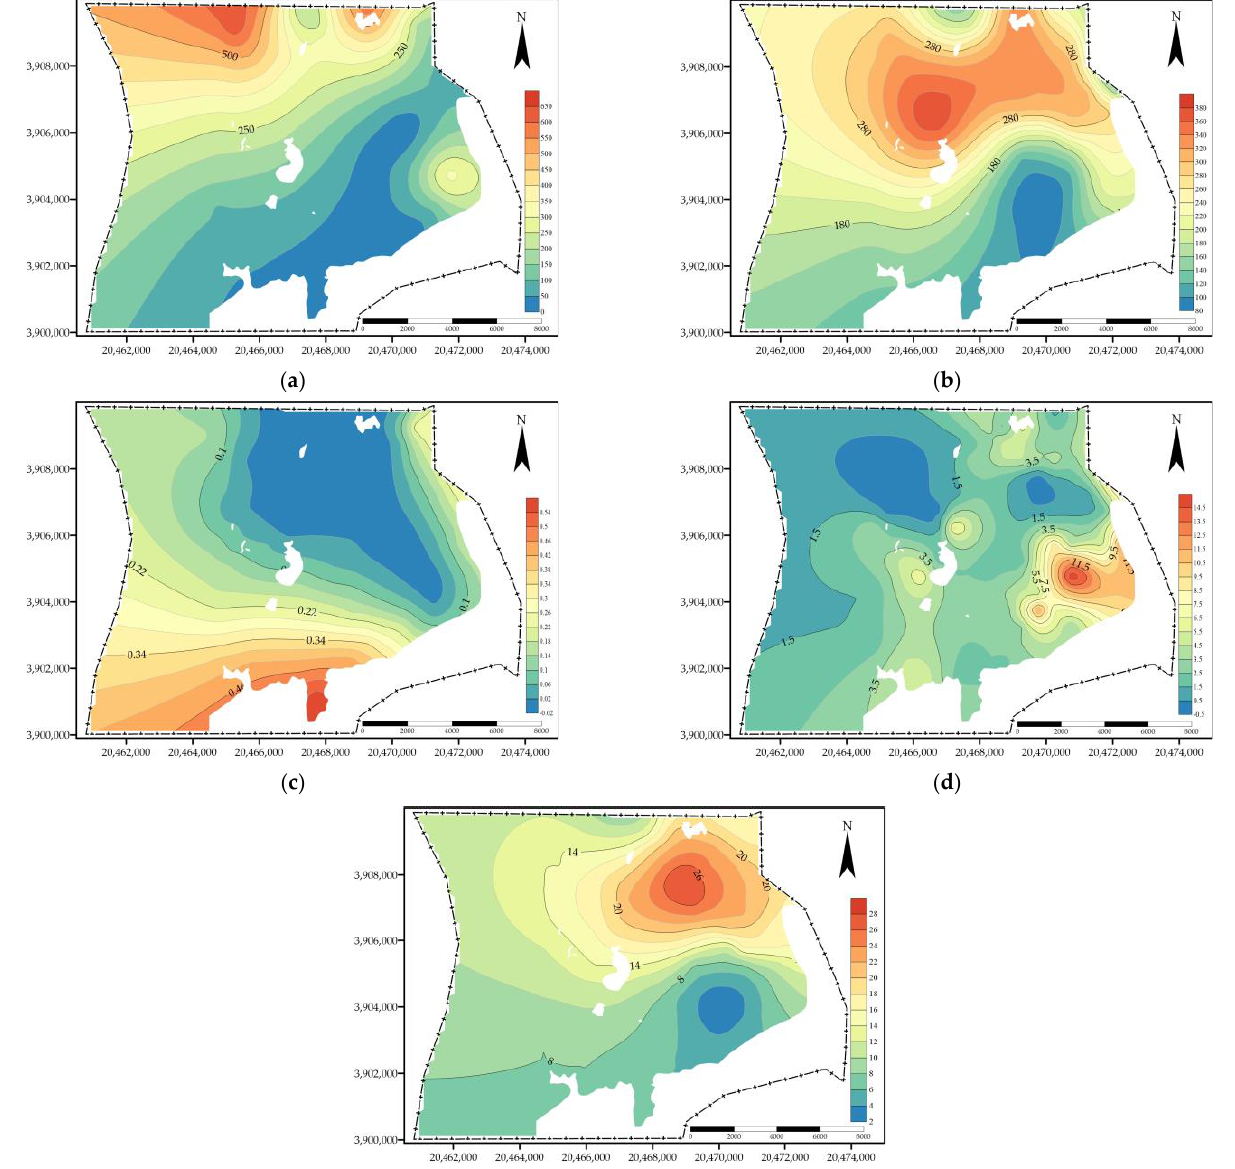
Figure 4. Factors of roof water inrush of aquifer properties: ( a ) burial depth (Dp); ( b ) aquifer thickness (Tk); ( c ) core collection rate (Cr); ( d ) brittle – plastic rock thickness ratio (Tkr); ( e ) number of aquifers and barriers (Num)